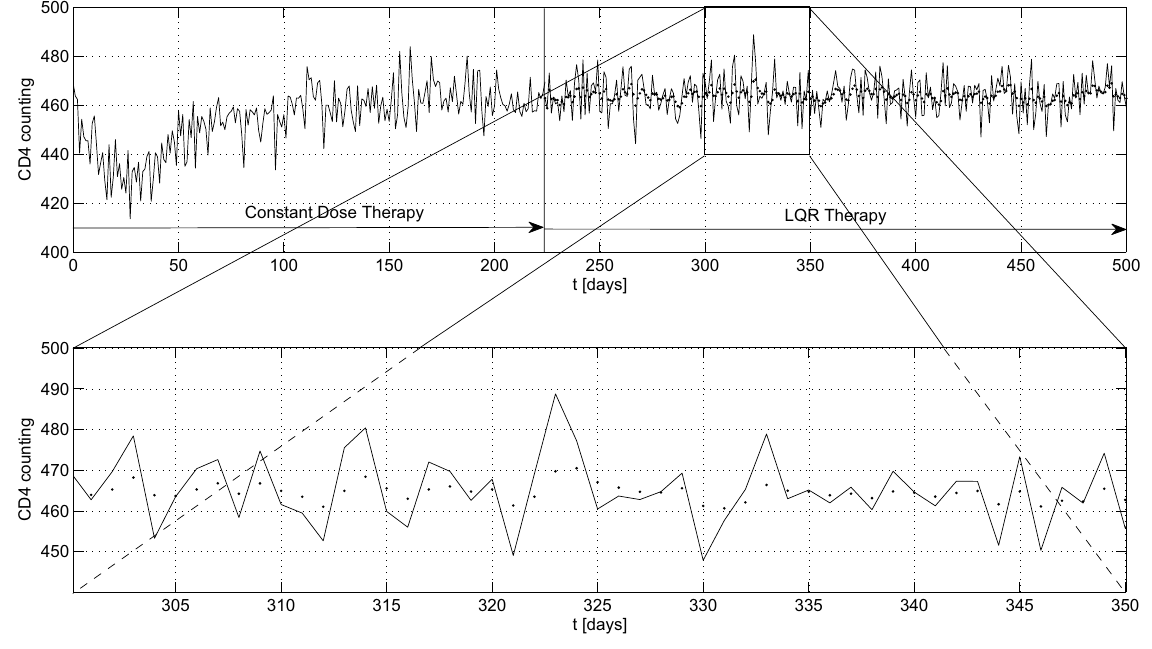
Fig. 1 – Comparison between the actual measurements of CD4 + T cells, affected by uncertainty (solid line) and the estimated values obtained by using extended Kalman Filter